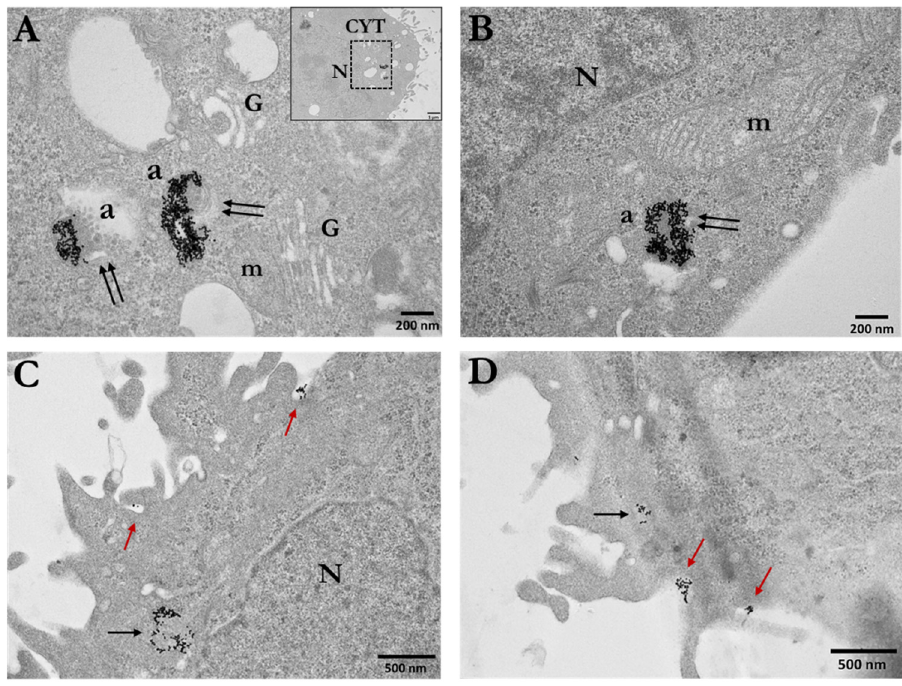
Figure 3. Electron micrographs of PC3 cells incubated for 24 h with 15 nm Ct-AuNPs (30 μ g/mL). ( A , B ) Images show the distribution and localization of Ct-AuNPs in different cells. NPs were located in autophagosomes or autolysosomes (double arrows). ( C , D ) Nanoparticles were seen located in the cytoplasm and in vesicles (black single arrows). Red arrows indicate the mechanism by which the cell may internalize AuNPs via endocytosis. N: nucleus, m: mitochondrion, a: autophago- some/autolysosome, G: Golgi apparatus, CYT: cytoplasm. The box with dotted line in the inset of ( A ) indicates the area of the cell depicted in the main figure at higher